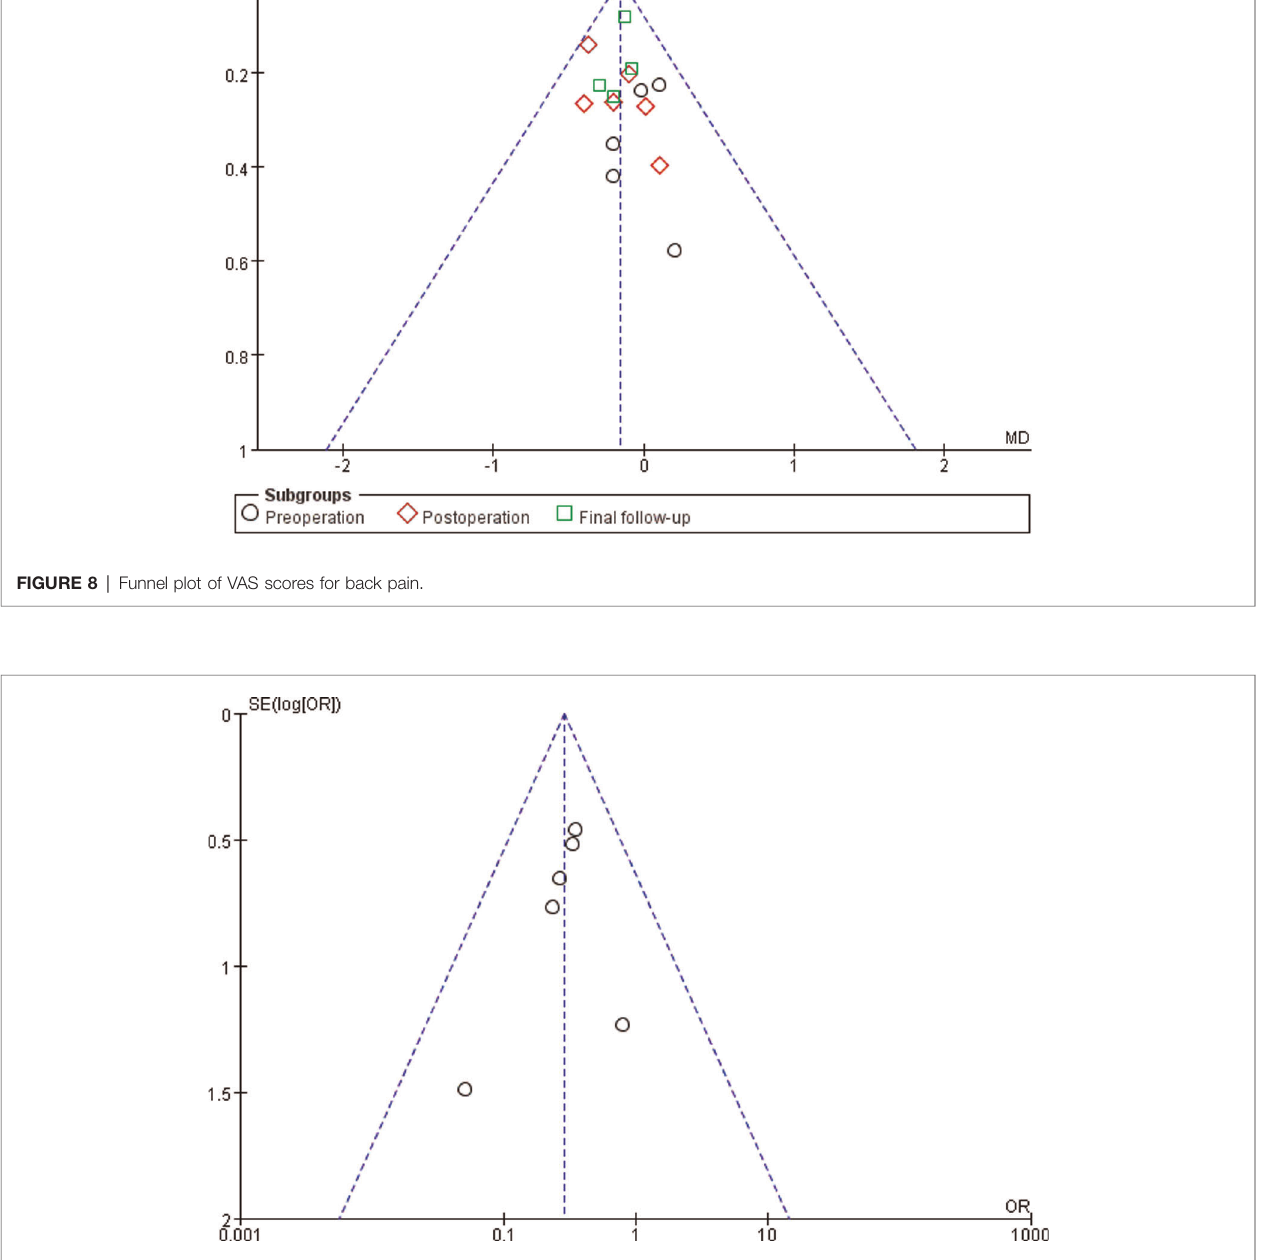
FIGURE 9 | Funnel plot of cement leakage